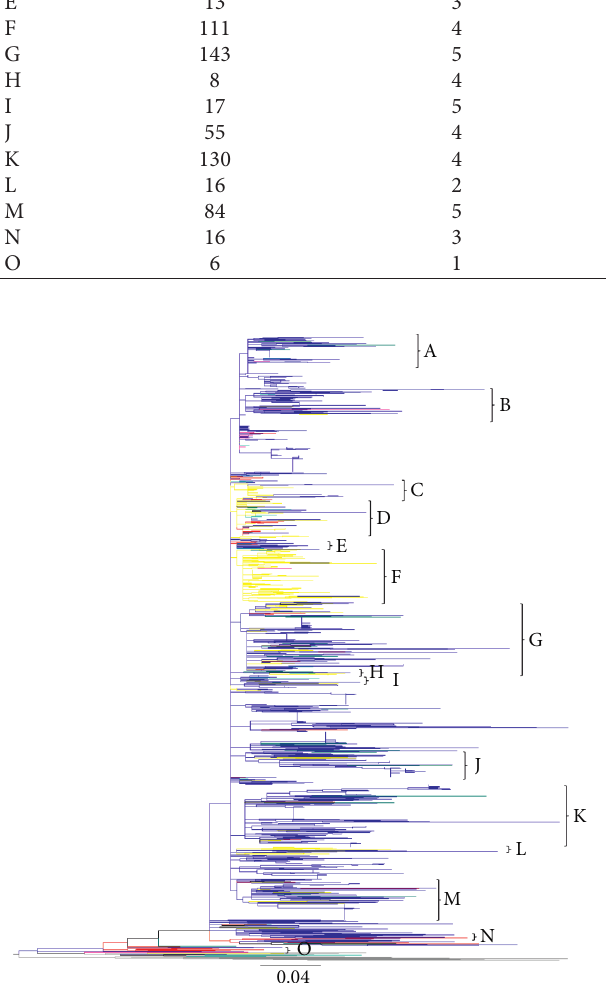
Figure 3: Phylogenetic relationship of HIV subtype A env gene sequences from FSU countries: For the construction of the phy- logenetic tress, a stretch of HIV sequence corresponding to HBX2 nucleotide 7071–7336 was used. The sequences are included from Armenia, Belarus, Georgia, Estonia, Kyrgyzstan, Latvia, Moldova, Russia, Ukraine and Uzbekistan represented by, respectively, teal, green, purple, pink, neon, yellow, olive, dark blue, red, and tur- quoise branches. The branches coded grey represent 12 outgroup reference sequences that were used to root the